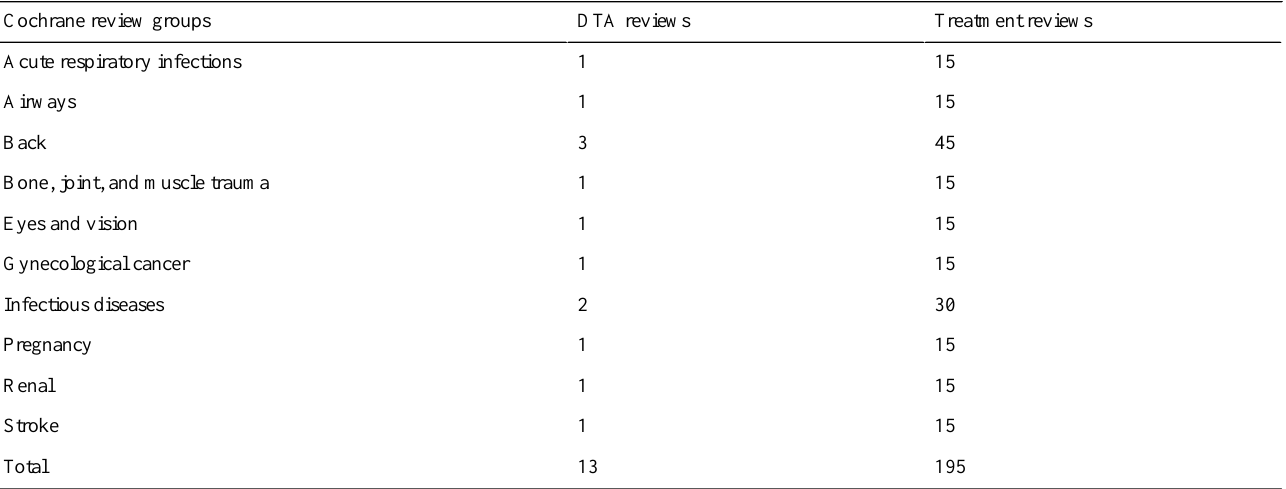
Table 2. Summary of the total number of DTA and treatment reviews randomly selected for inclusion in our analysis, ordered by CRG.